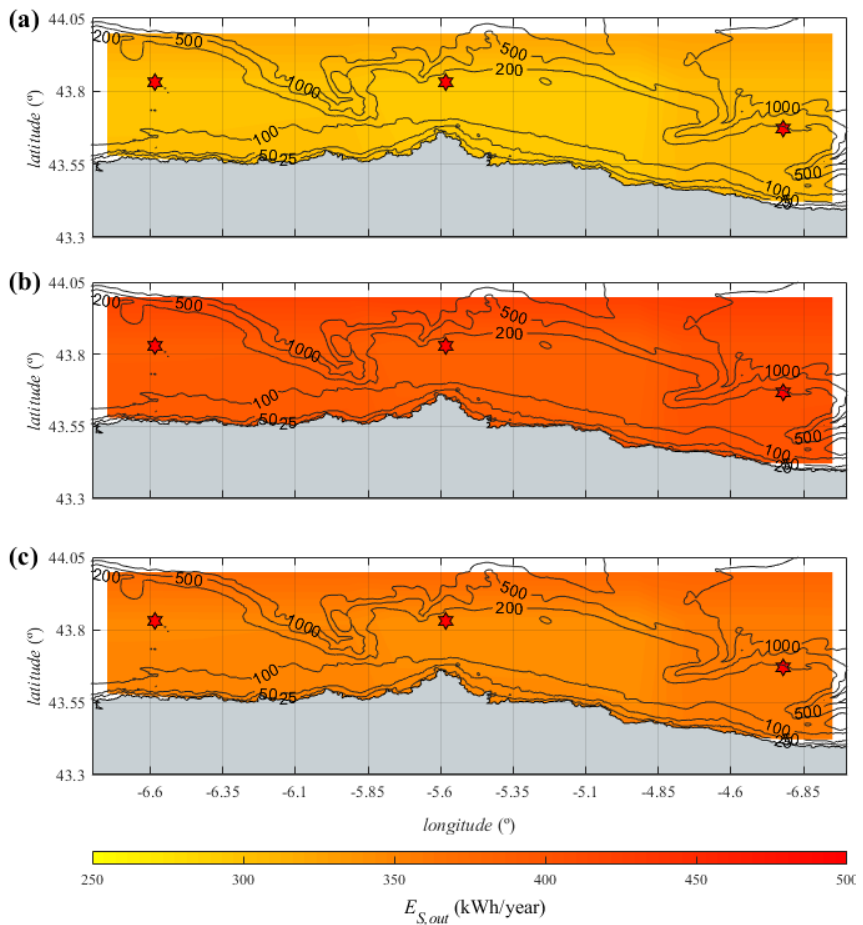
Figure 9. Expected solar energy output for three different commercial solar panels: Q-Power-G5 280 ( a ), Tallmax TSM-DE ( b ), and JKM 325PP-72V ( c ). The three study sites (West, Centre and East) are marked with red stars. (Water depths in m).